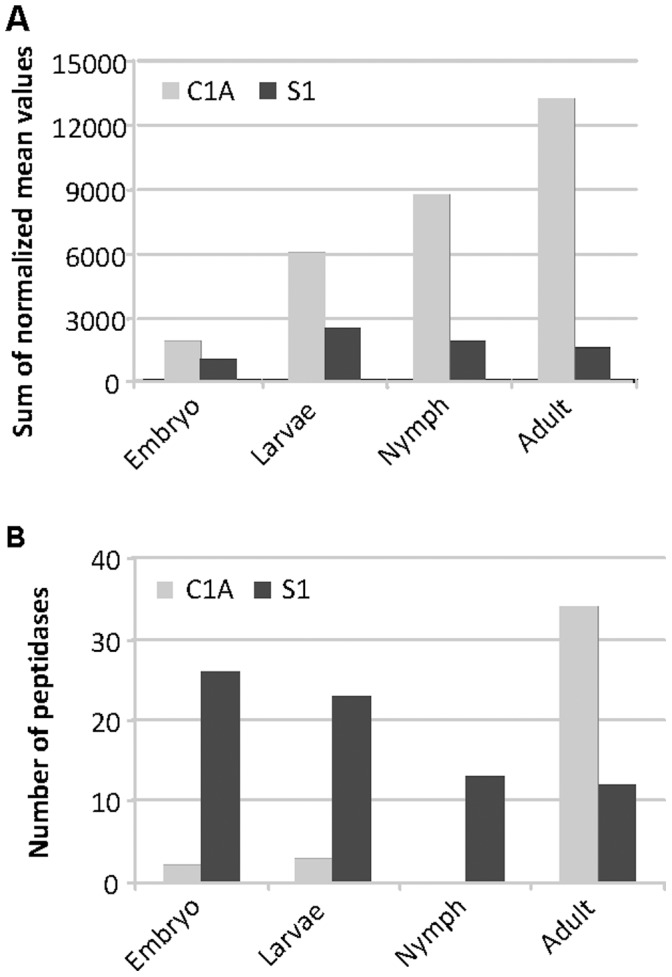
Expression profiling of C1A cysteine and S1 serine peptidase families in T. urticae.
A. Sum of the normalized expression values for all C1A and S1 family members in each developmental stage analyzed. B. Number of genes for the C1A cysteine and S1 serine peptidase groups assigned to the developmental stage (embryo, larvae, nymph and adult) in which their highest expression was detected.